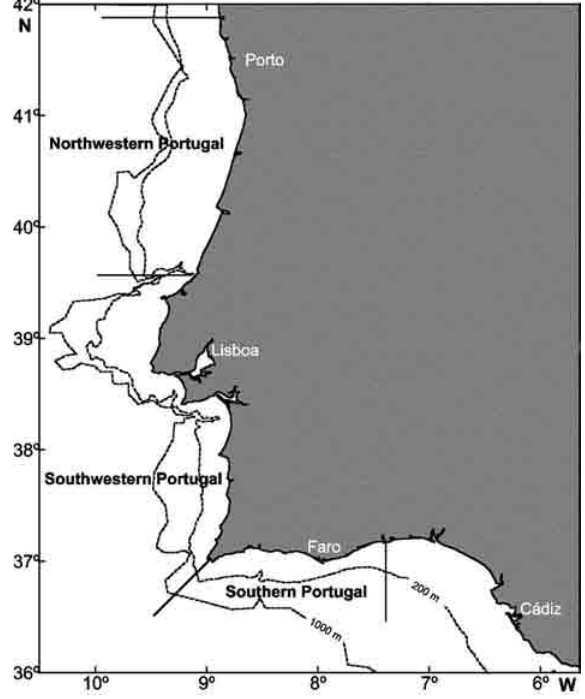
F IG . 1.– Map of the study area divided by